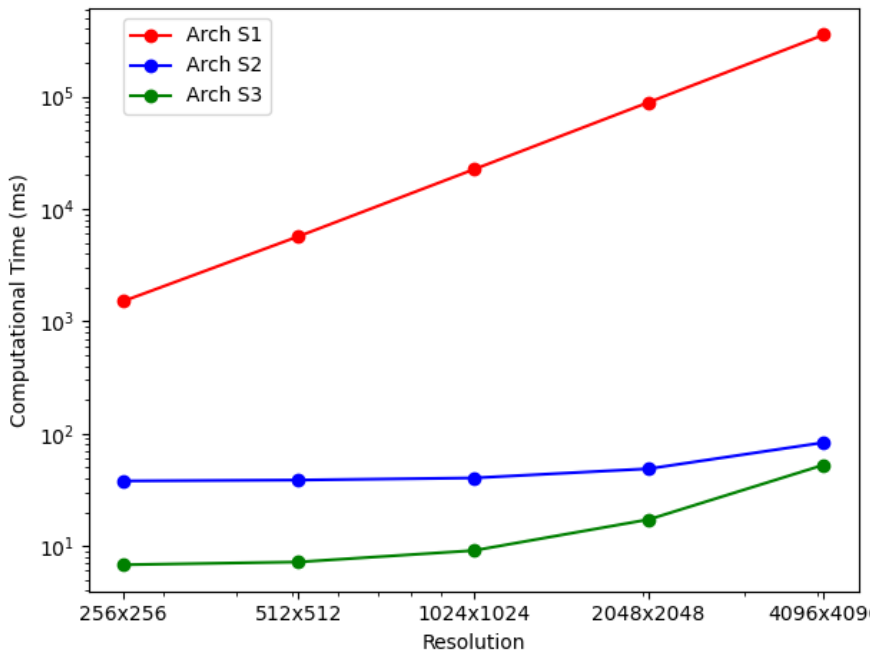
Figure 10. BP-VISAR frame generation time with sub-aperture processing in overlapped mode ( α =